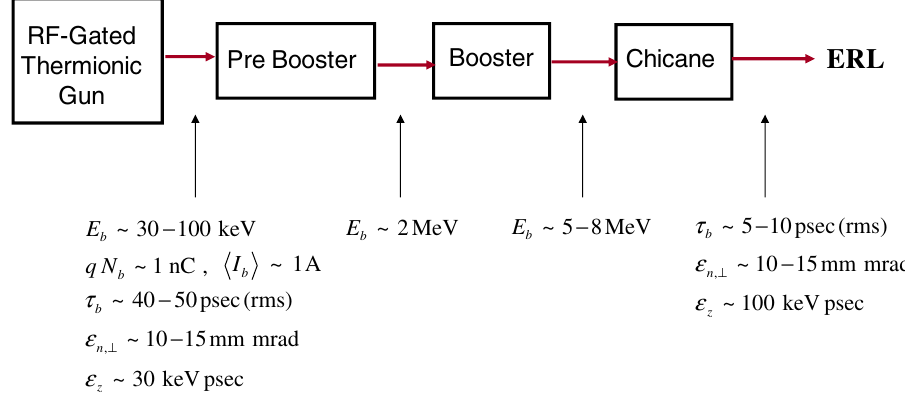
FIG. 1. Schematic of injector for an FEL employing an energy recovery linac (ERL). The source of electrons is an rf-gated, gridded thermionic gun. Electrons are accelerated in booster cavities and bunched in a magnetic chicane before entering the ERL. Typical electron beam parameters associated with the stages are indicated in the figure. Additional bunching is achieved in the ERL and a chicane just before the